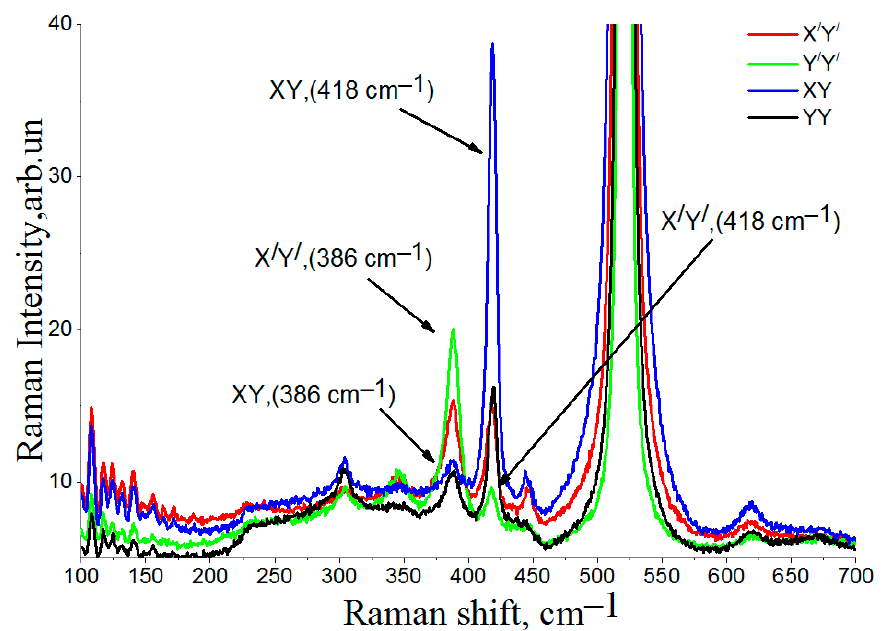
Figure 3. Polarized Raman scattering spectra with different polarizations of incident and scattered light for the L1 region.